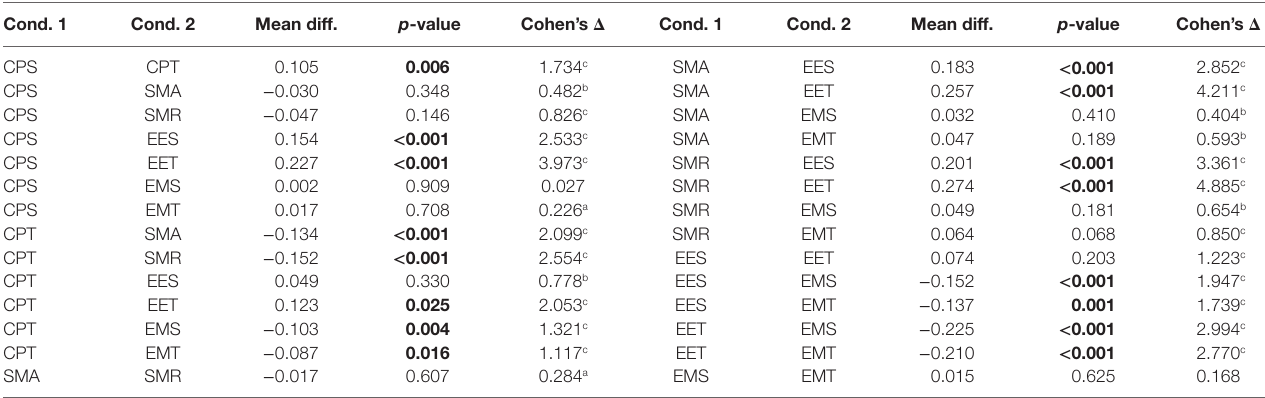
TaBle 2 | Predictors post hoc results.